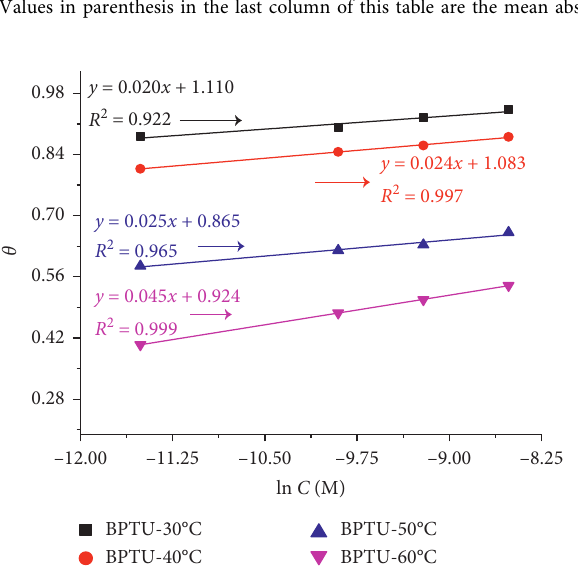
Figure 9: Temkin’s adsorption isotherm of BPTU on the steel surface in 1.0M HCl.